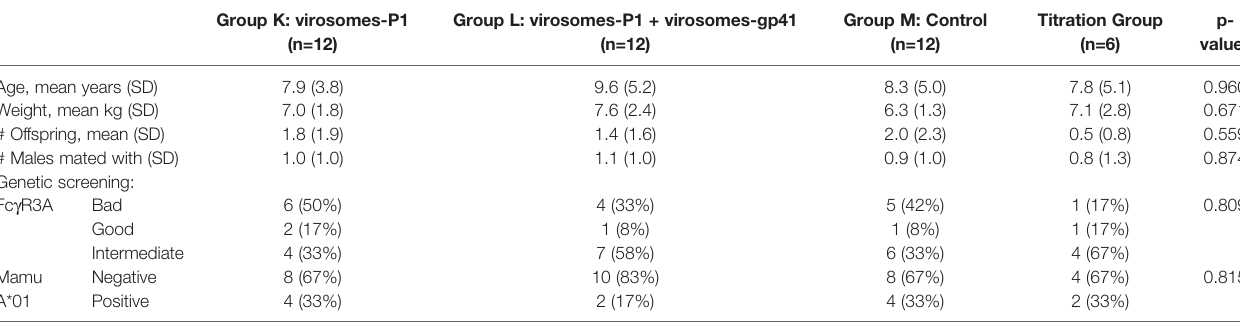
TABLE 1 | Distribution of demographic factors across Indian RMs of the different study groups. Group K: virosomes-P1